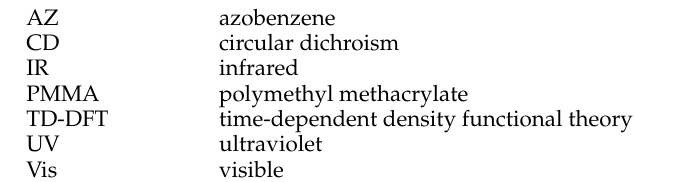
Figure S1: Optimized structure of Ni with dipole moment (arrow). Figure S2: Optimized structure of Cu with dipole moment (arrow). Figure S3: Optimized structure of Zn with dipole moment (arrow). Figure S4: PMMA concentration dependence of acetone solutions of Ni , Cu , and Zn . Table S1: The R and S values of polarized IR spectra for Ni+AZ+PMMA . Table S2: The R and S values of polarized IR spectra for Cu+AZ+PMMA . Table S3: The R and S values of polarized IR spectra for Zn+AZ+PMMA . Table S4: The R and S values of polarized UV-Vis spectra for Zn+AZ+PMMA . Table S5: The R and S values of polarized UV-Vis spectra for Ni+AZ+PMMA . Table S6: The R and S values of polarized UV-Vis spectra for Cu+AZ+PMMA . Acknowledgments: The computations were performed at the Research Center for Computational Science, Okazaki,